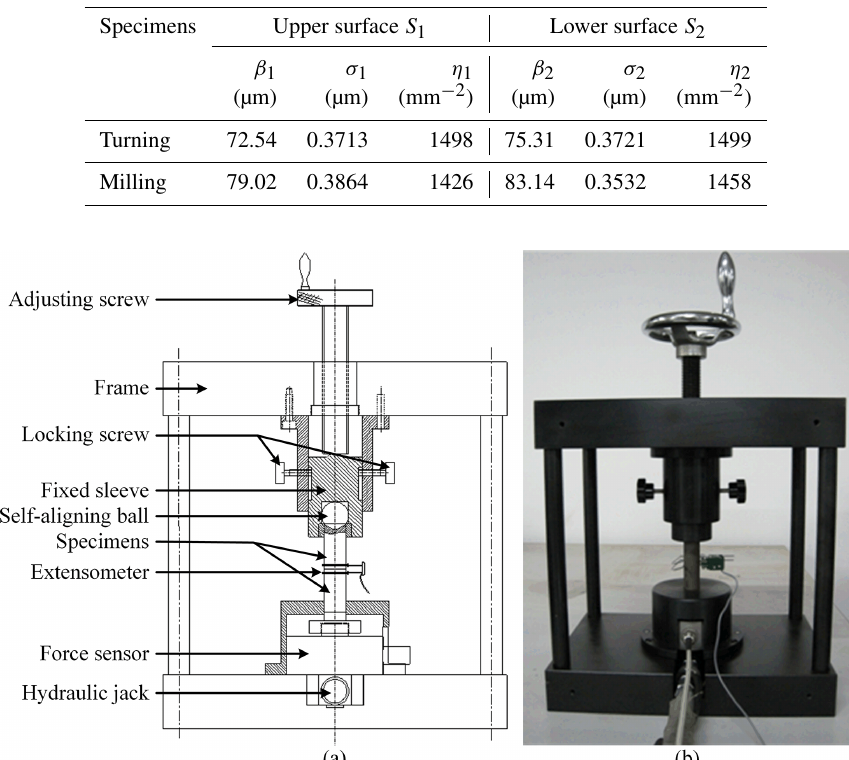
Figure 11. Experiment set-up of normal contact stiffness. (a) Schematic diagram and (b) real experiment set-up.